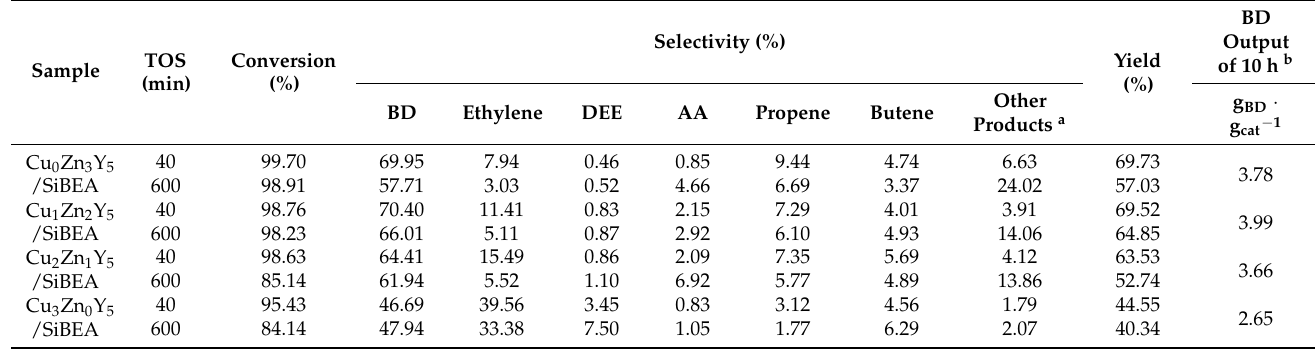
Table 4. The catalytic performances of catalysts with different Cu/(Cu + Zn) mass